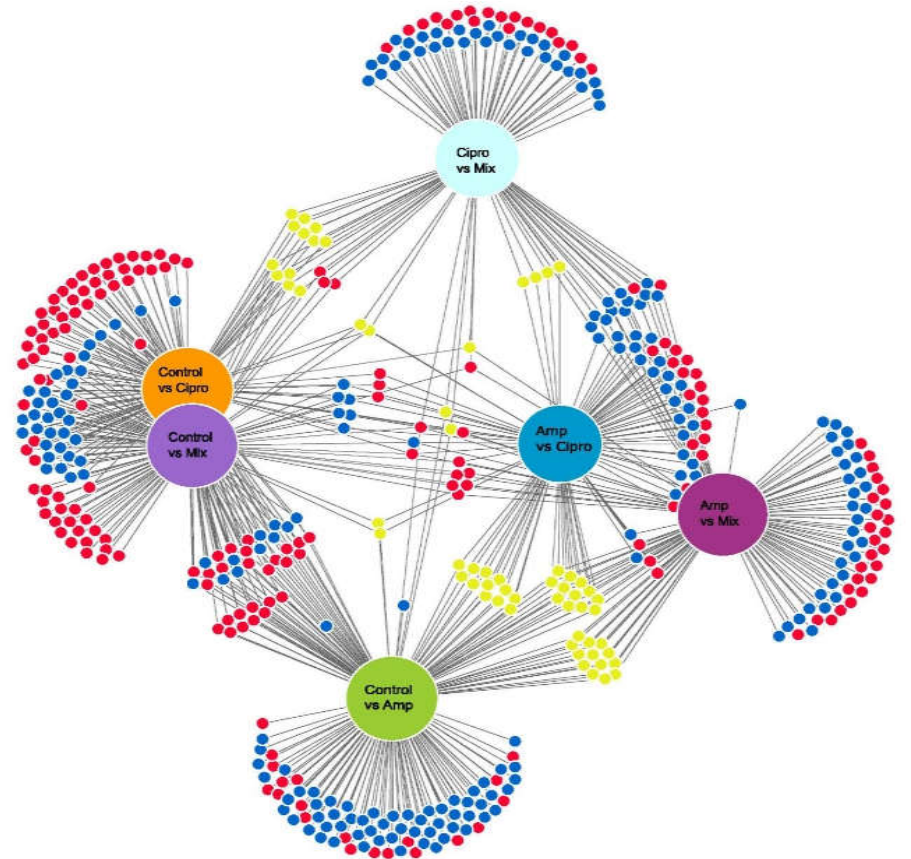
Figure 5. Venn diagram showing the number of genes differentially expressed genes in Symbiochloris reticulata , the green-algal photobiont of Lobaria pulmonaria , identified by pairwise Wald test comparisons for antibiotic treatments. Downregulated: blue, upregulated: red, up/downregulated: yellow circles. Thresholds for inclusion were log 2 -fold change (>1.5=upregulated; < − 1.5=downregulated) and Benjamini–Hochberg adjusted p -value ( p < 0.05).